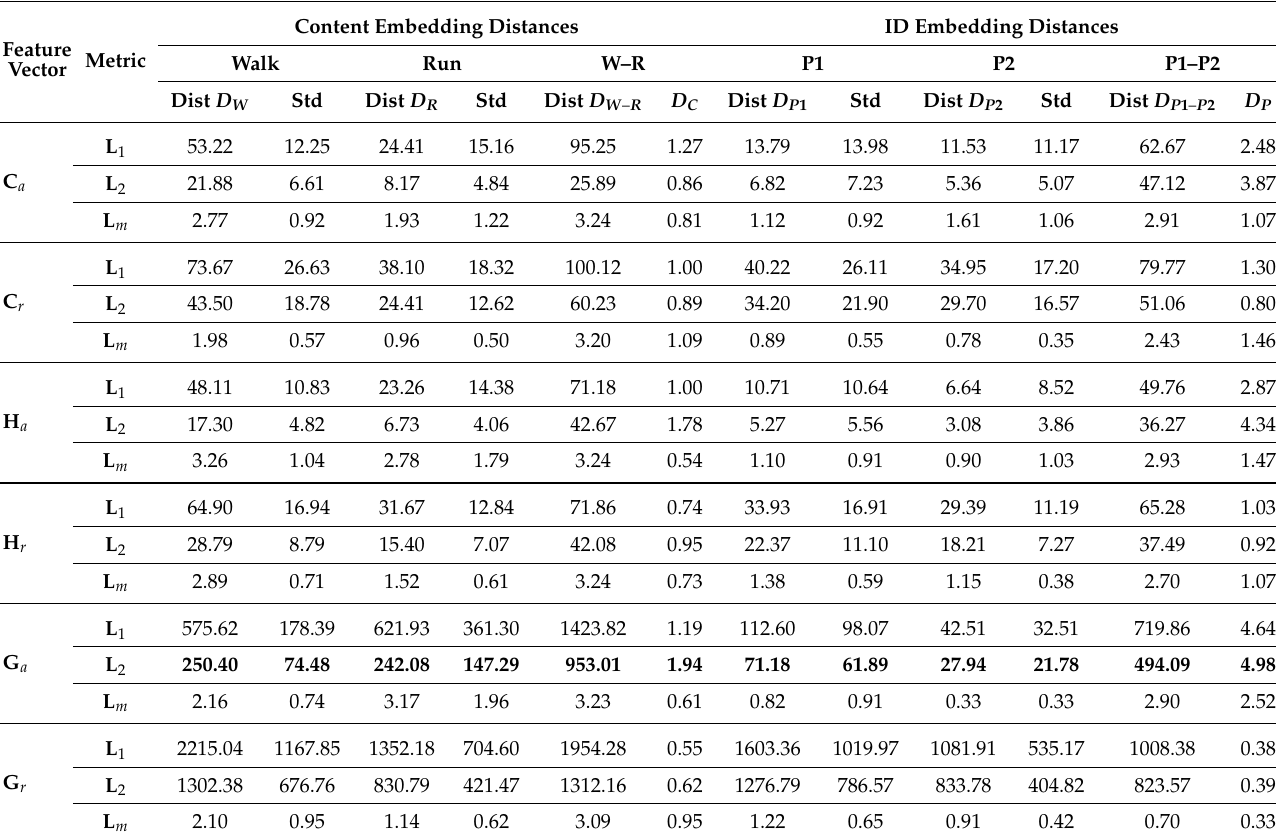
Table 1. Motion embedding statistics. The columns of Dist and Std list the average distance and standard deviation of samples from the same motion type and person. W–R indicates the distance between the cluster centroid of walking and running, while P1–P2 indicates the distance between the cluster centroid of two persons: P1 and